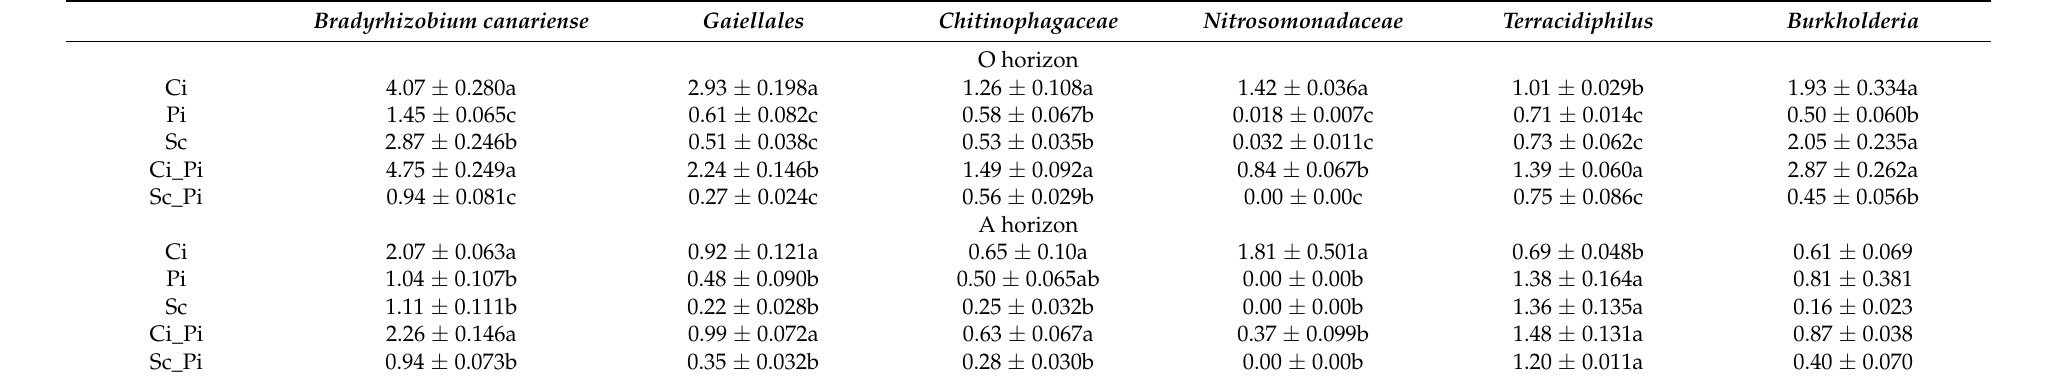
Table 3. The soil bacteria that were significantly more abundant in Ci and Ci_Pi. Different letters indicate a significant difference among forest types, respectively in the O horizon and A